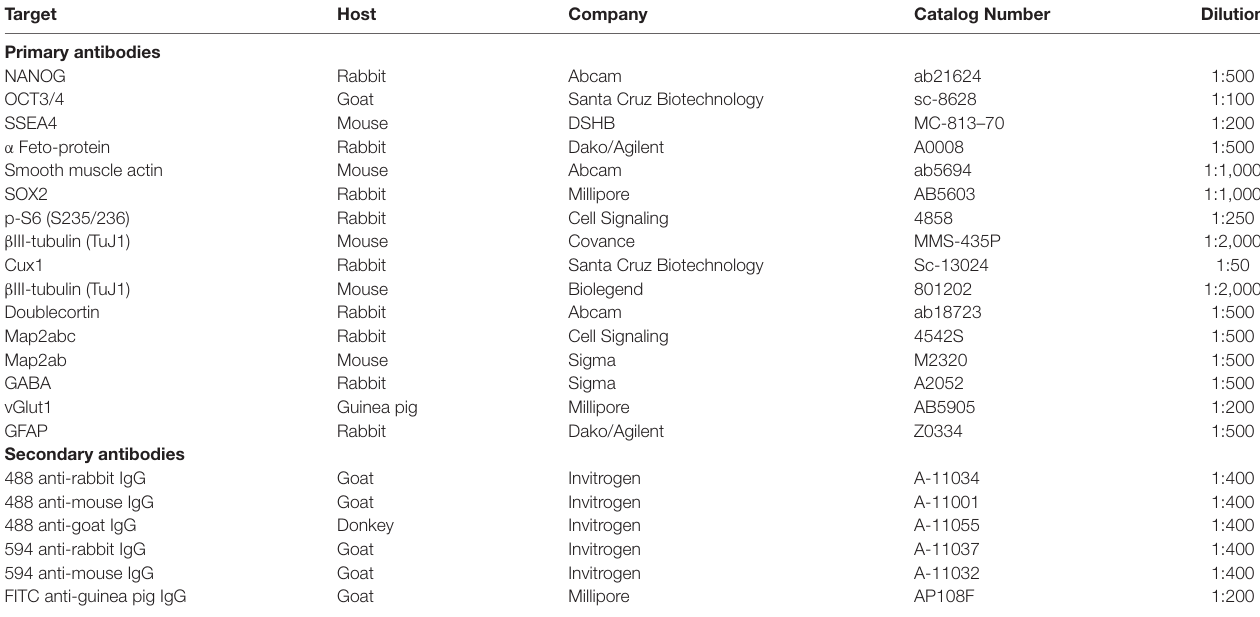
TABLE 1 | Primary and secondary antibodies used for ICC.